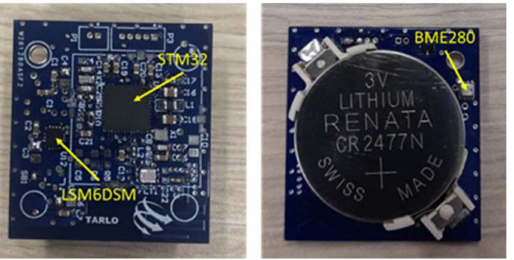
Figure 1. Representation of the hardware of the developed sensor